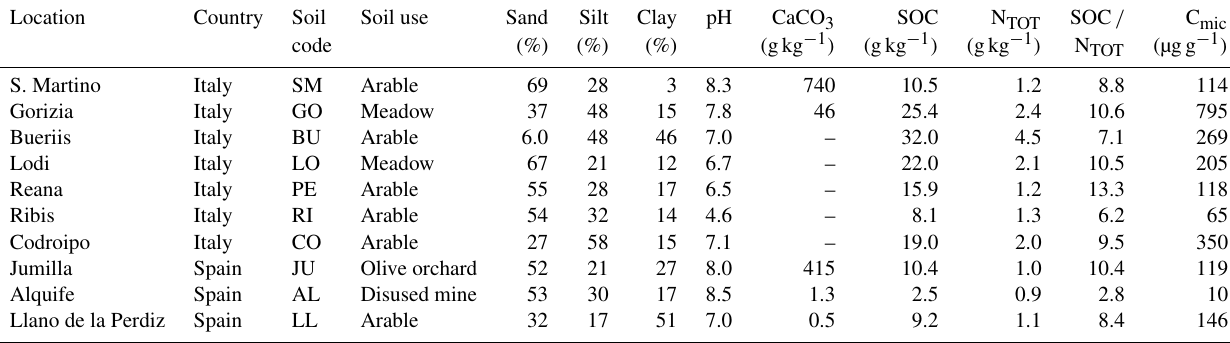
Table 2. Main physicochemical characteristics of the soils used for incubation. Location Country Soil Soil use Sand Silt CaCO 3 code